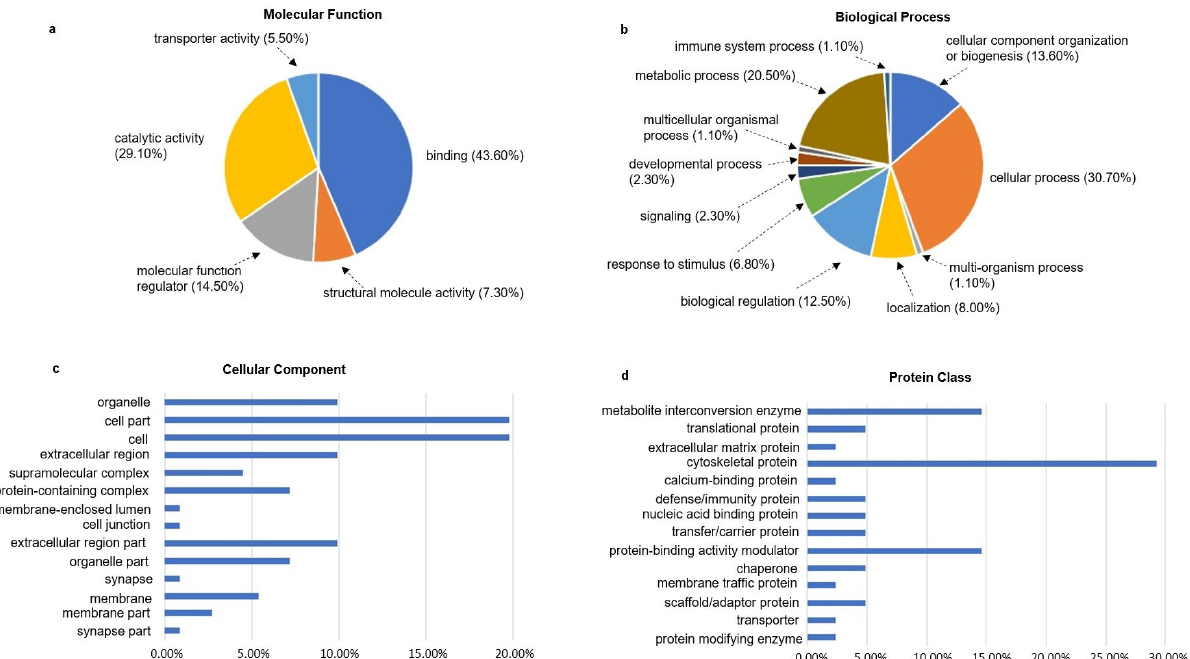
Figure 3. This figure summarizes gene ontology analysis of the ncAA-containing proteins in bladder ischemia. The ncAA-containing proteins (R2 > 0.5, ratio > 2-fold, p < 0.05) in the ischemic bladder tissues were categorized using the PANTHER database. Changes in molecular function, biolog- ical process, cellular component, and protein class are presented in sections ( a ), ( b ), ( c ), and ( d ), respectively. These figures are taken from our previous publication